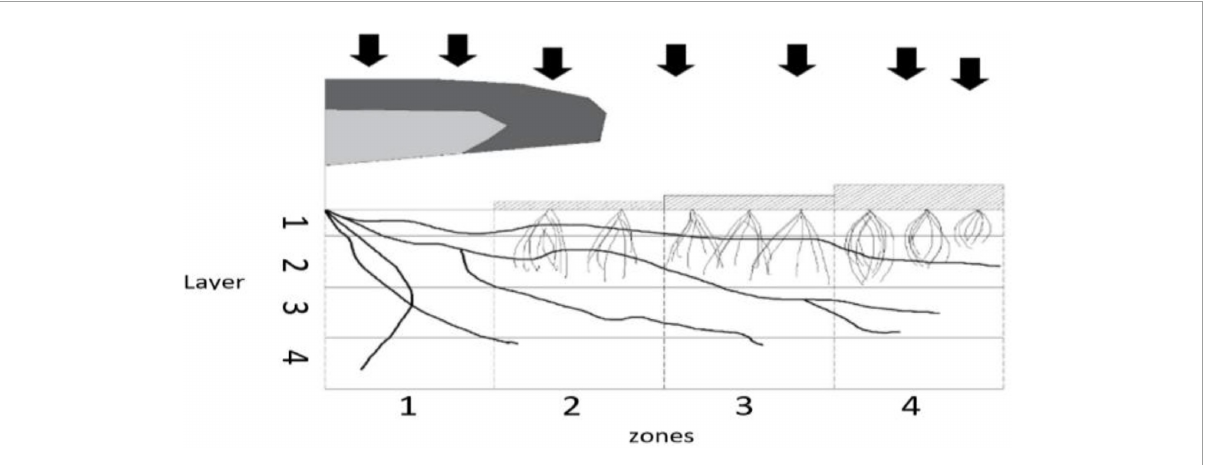
FIGURE2 WaNuLCAS 2D spatial discretization with four soil depths (vertical layers) and four distance zones from a tree (horizontal layers), and the same is applied to the above ground canopy for light